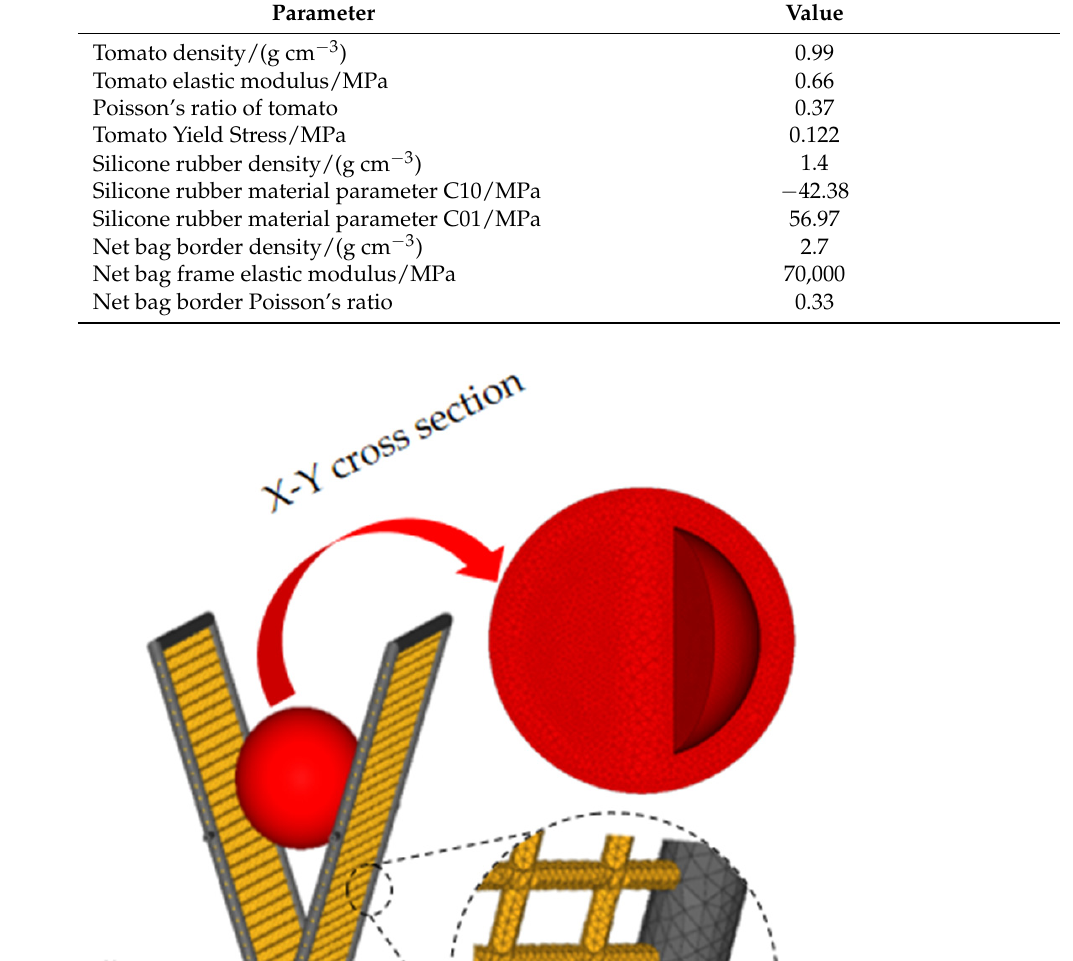
Table 2. Material parameter setting.